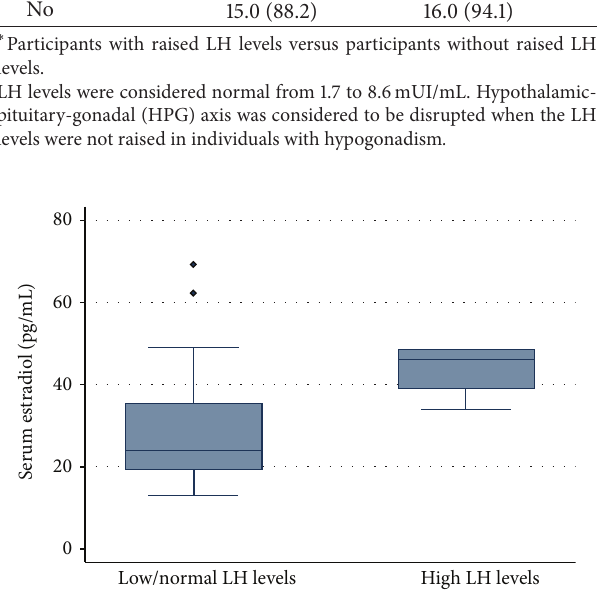
Figure 2: Box-plot representation showing a statistical significant increase of the estradiol levels (vertical axis) with the increase of the luteinizing hormone levels (LH) (horizontal axis) ( 𝑃 = 0.033 ).